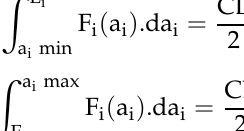
Algorithm for accuracy trade-o ff in state estimation